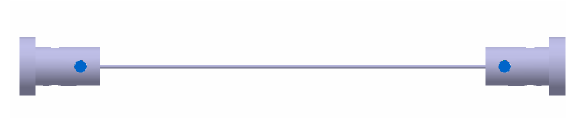
Figure 4 . The installation of SMA